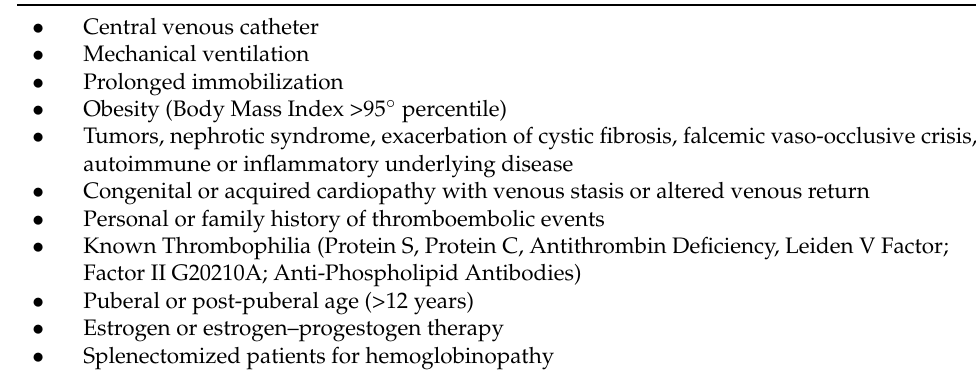
Table 7. Risk factors for thrombosis.